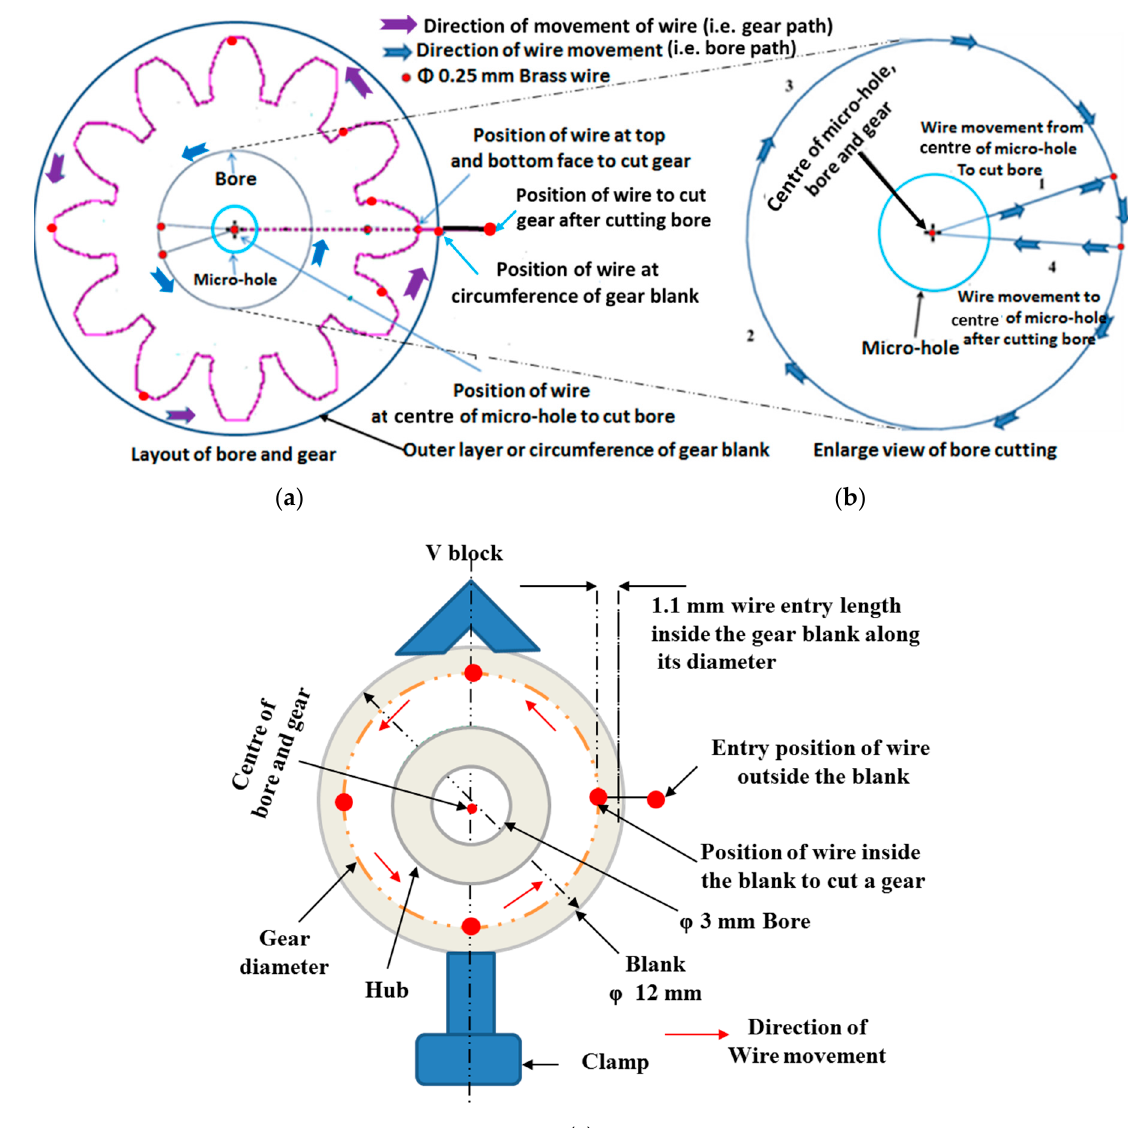
Figure 4. Layout of miniature gear with bore and direction of the wire movements during cutting of bore and gear by WTEM process: ( a ) gear and bore; ( b ) enlarge view of bore along with the path of wire movement, and ( c ) schematic diagram of gear blank, V block, clamp, and wire entry position for cutting miniature gear.